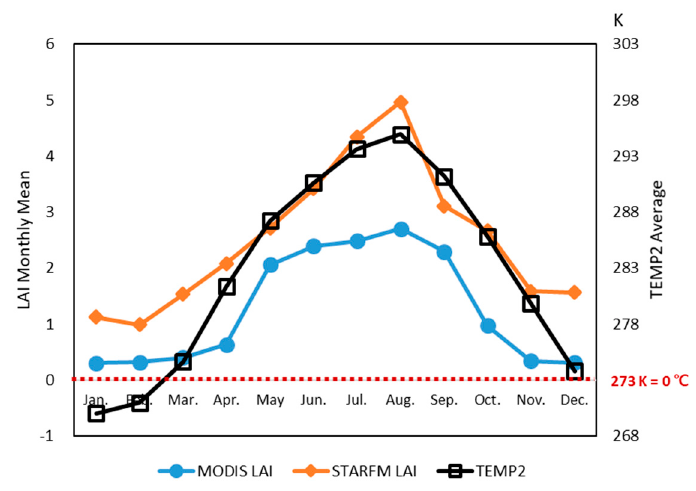
Figure 7. Comparison between Leaf Area Index (LAI) monthly mean estimates and 2-m-above-ground temperature (TEMP2) monthly Weather Research and Forecasting (WRF) model data averages for the Korean Peninsula.